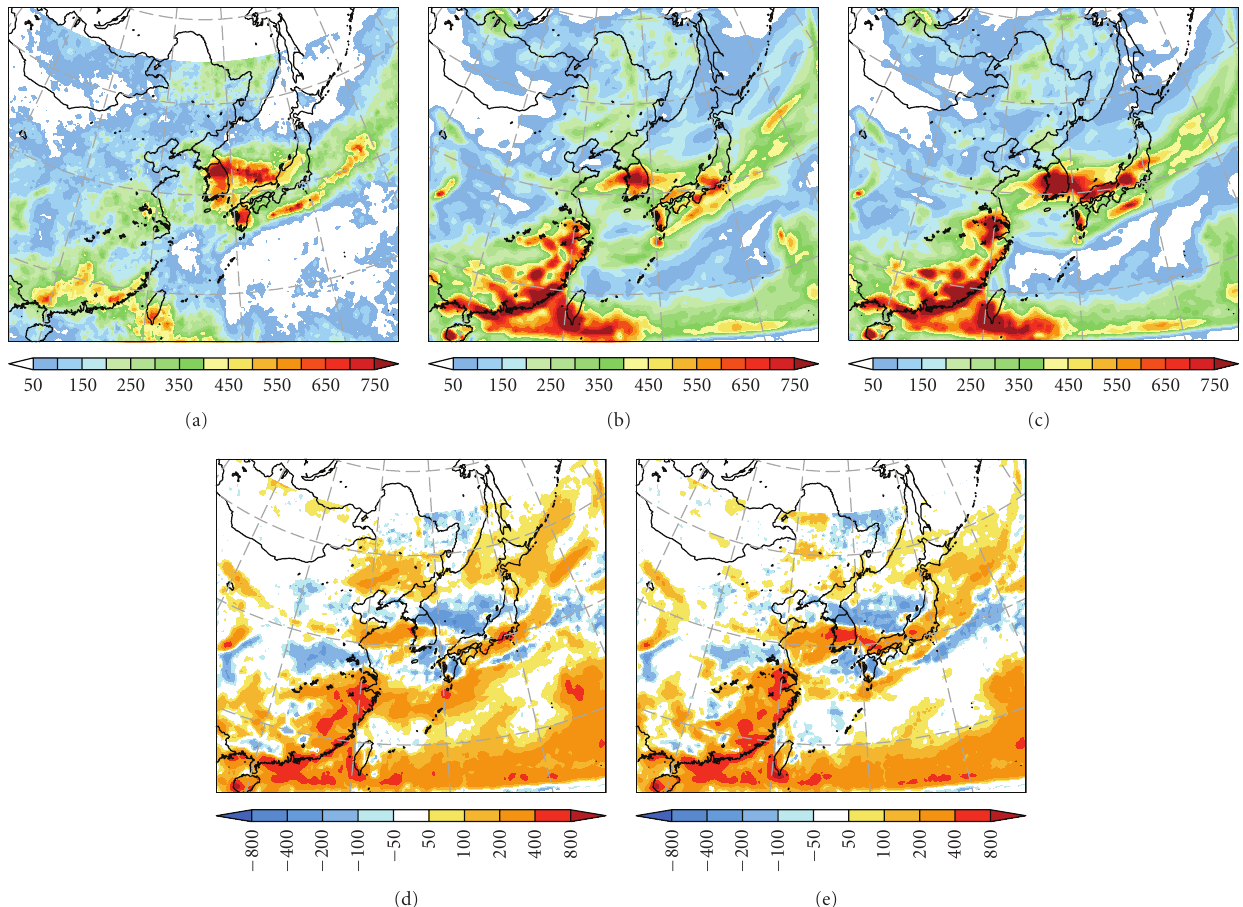
Figure 4: One-month accumulated rainfall (mm) from 0000 UTC 1 July to 0000 UTC 1 August 2006, obtained from the (a) TMPA observation, (b) WSM6, and (c) WDM6 experiments. Di ff erences in 7 one-month accumulated rainfall (mm) between the observation and the (d) WSM6 (WSM6-TMPA) 8 and (e) WDM6 experiment (WDM6-TMPA). Table 1: The pattern correlation coe ffi cients (PC), bias score, and root mean square error (RMSE) of the 24 hours accumulated precipitation over South Korea with respect to surface observation, ending at 00 UTC 15 July 2001, for 5-km(45km) resolution. Over the lands Over the oceans PC Bias score RMSE PC Bias score